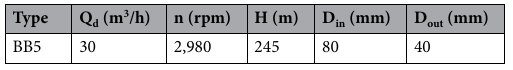
Table 1. Parameters of the multistage centrifugal pump.